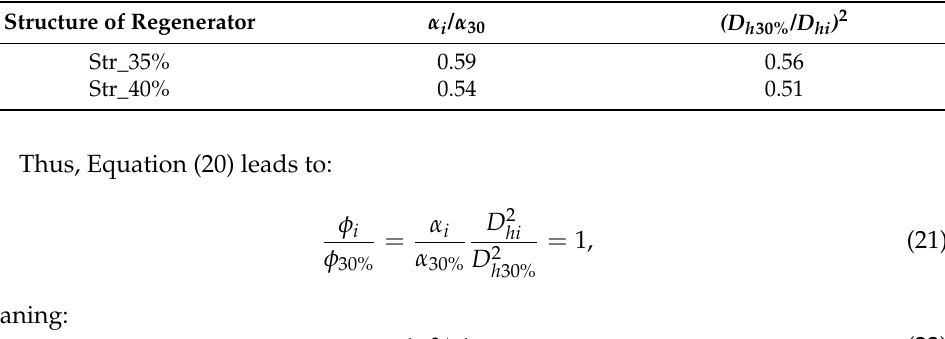
Table 4. Slope ratio and hydraulic diameter inversed